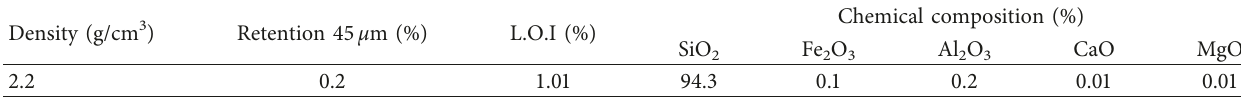
Table 5: Chemical composition and physical properties of zirconium.